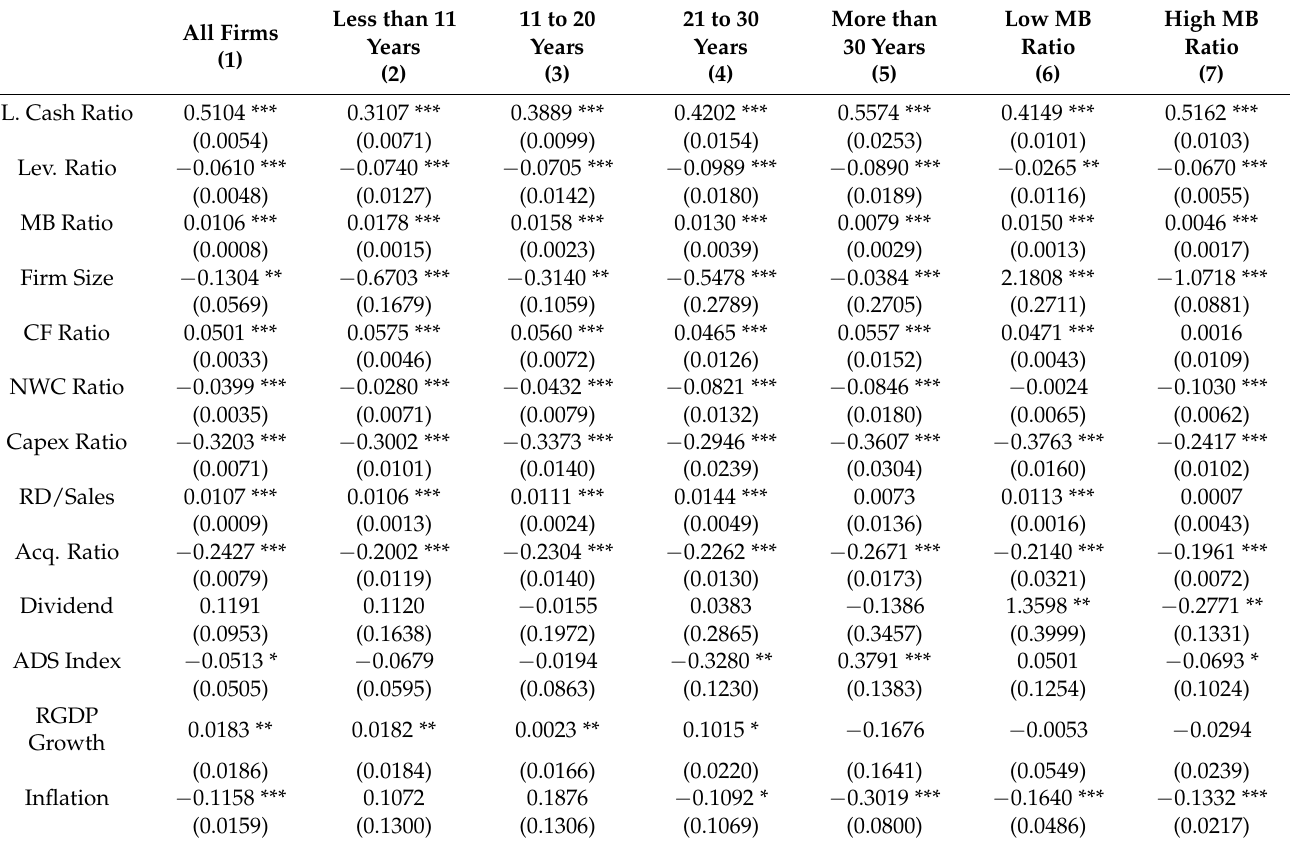
Table 7. Panel Instrumental Variables